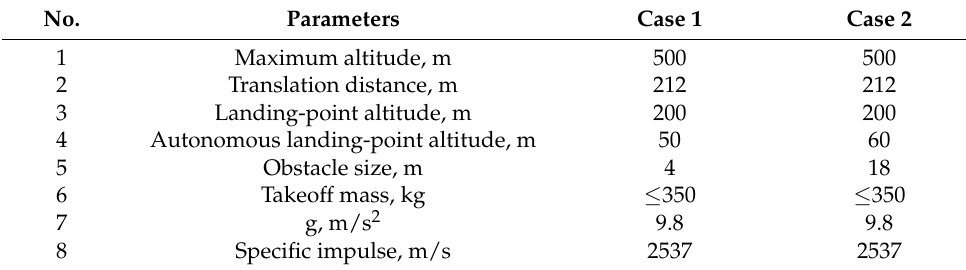
Figure 3. Third flight scenario sketch. Table 3. Design input for the third scenario.